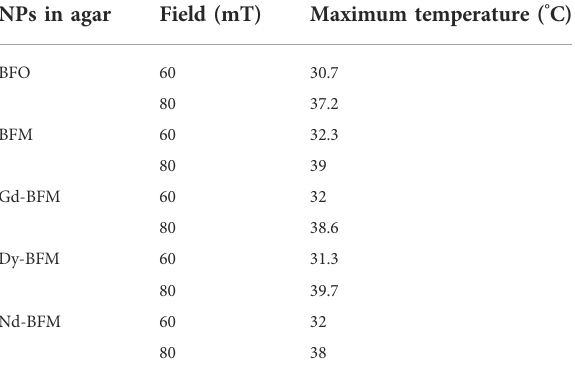
TABLE 2 Maximum measured temperature produced by 3 mg/ml of doped and undoped BFO NPs dispersed into Agar medium at different applied AC magnetic fi